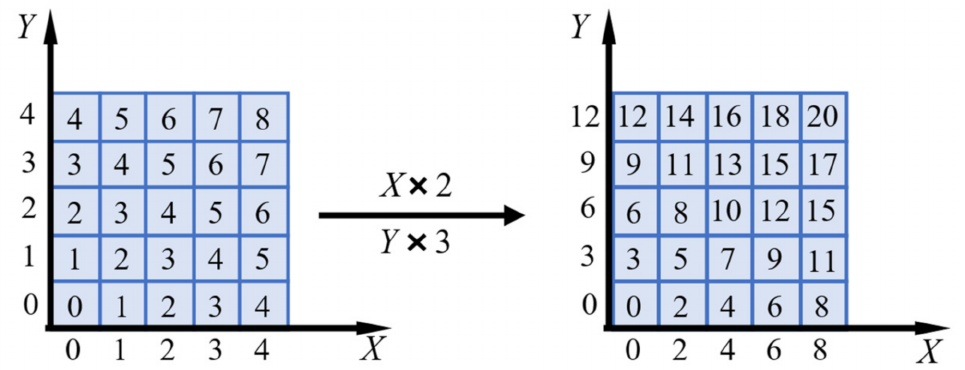
Figure 4. Establish a coordinate system based on the elements in the lower left corner, and expand the abscissa to twice the original size, and the ordinate to triple the original size. Such an encoding method can amplify the position information between elements and reduce the encoding repetition